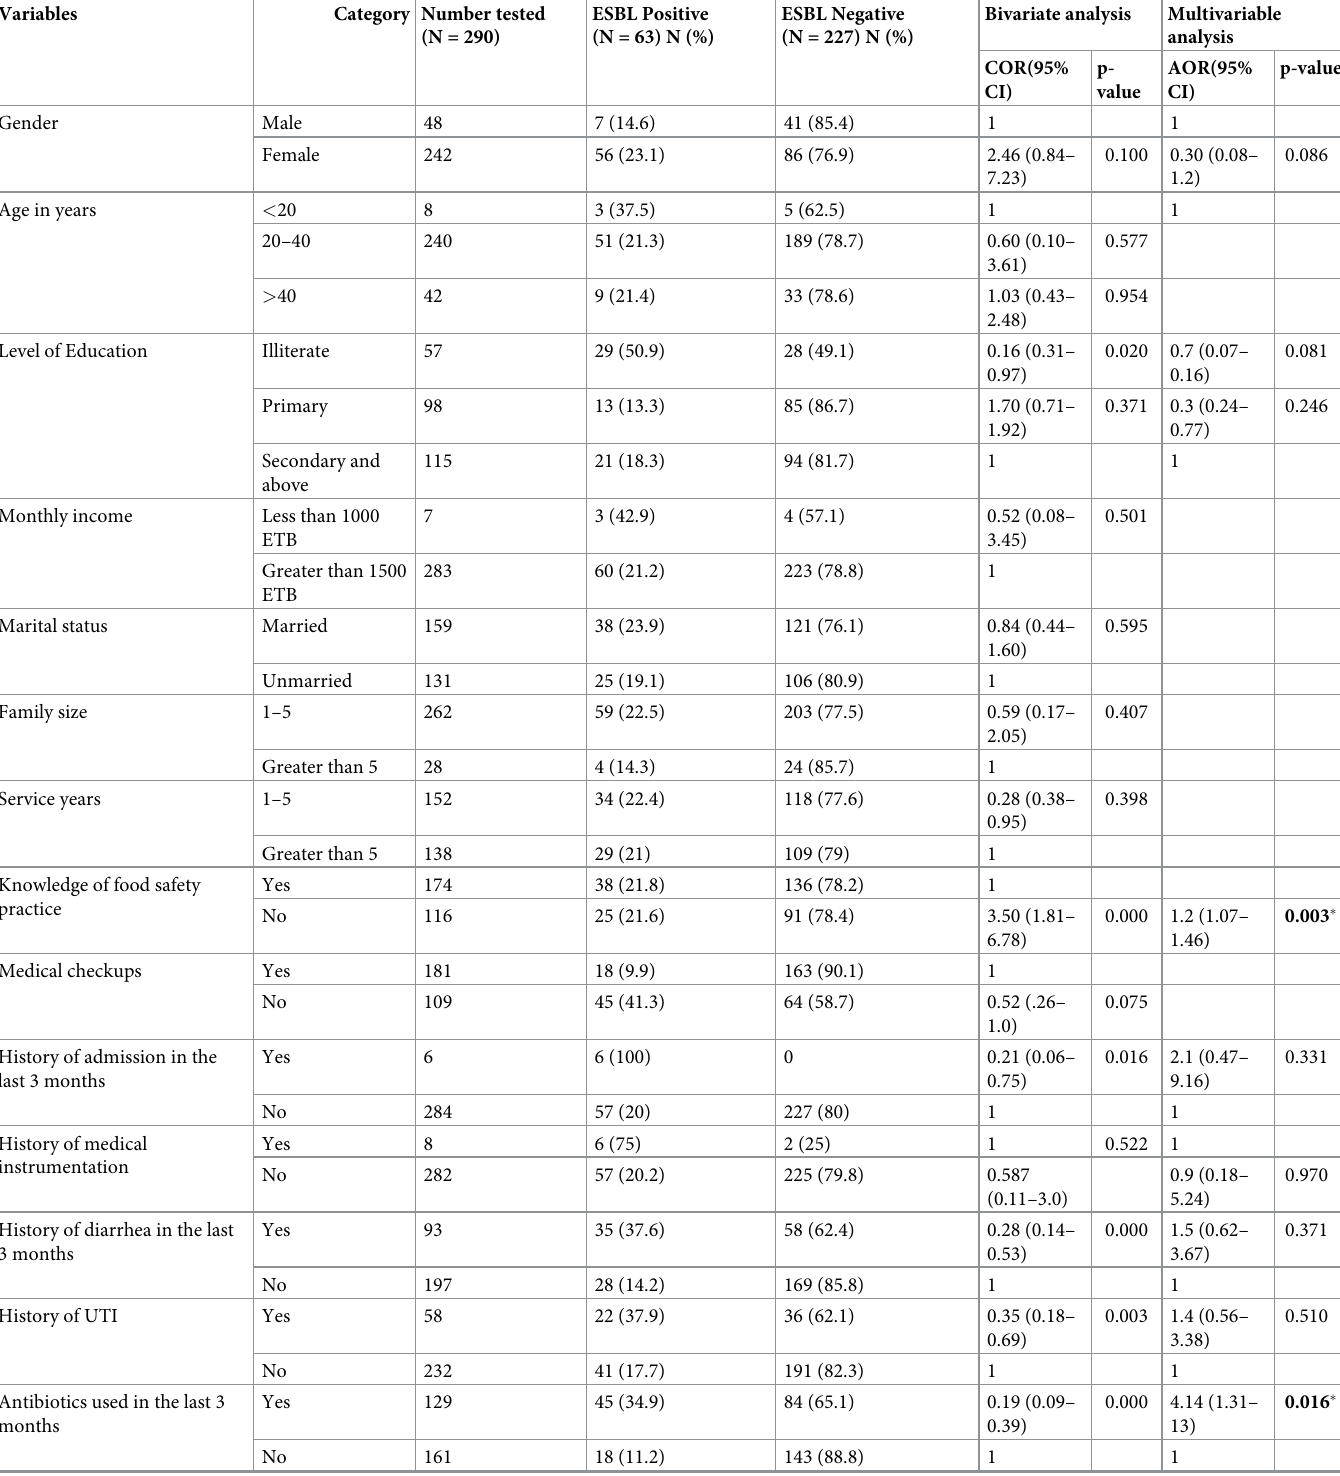
Table 7. Factors associated with fecal carriage rate of ESBL-PE among food handlers at the University of Gondar Specialized Hospital and students’ cafeteria, Northwest Ethiopia, February to June